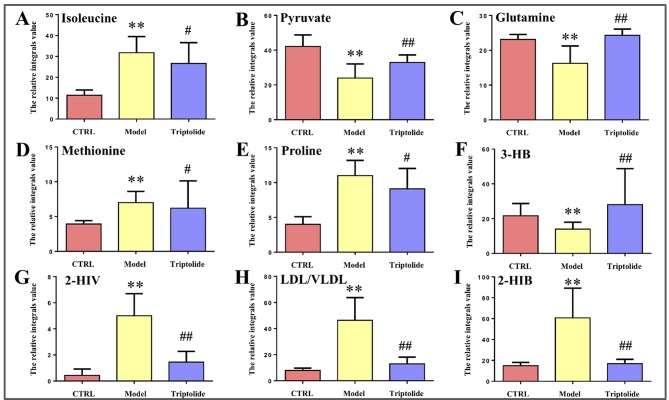
Relative integral levels of metabolites in normal control, model, and triptolide-treated groups. (A) Isoleucine; (B) Pyruvate; (C) Glutamine; (D) Methionine; (E) Proline; (F) 3-HB; (G) 2-HIV; (H) LDL/VLDL; (I) 2-HIB (**P < 0.01, model vs. control group; #P < 0.05, Triptolide vs. model; ##P < 0.01, Triptolide vs. model).